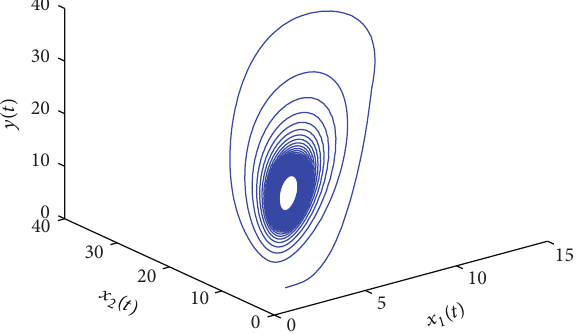
Figure 2: Phase portrait of model (5) with 𝜏 = 1.26 correspond- ing to stable dynamical responses in Figure 1, which shows that model (5) is asymptotically stable around the interior equilibrium (5.058, 14.932, 11.395) .